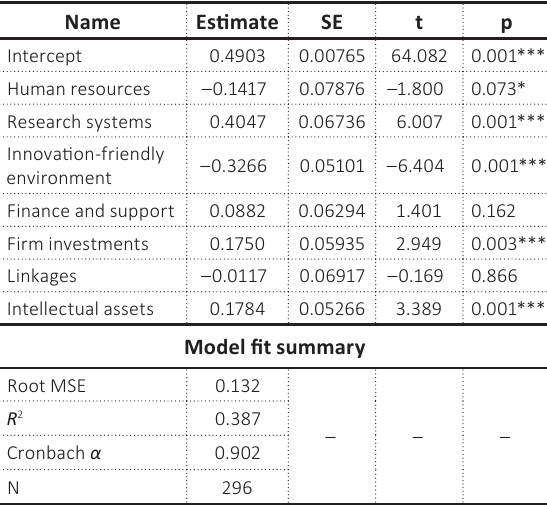
Table 3. Fixed effects parameter